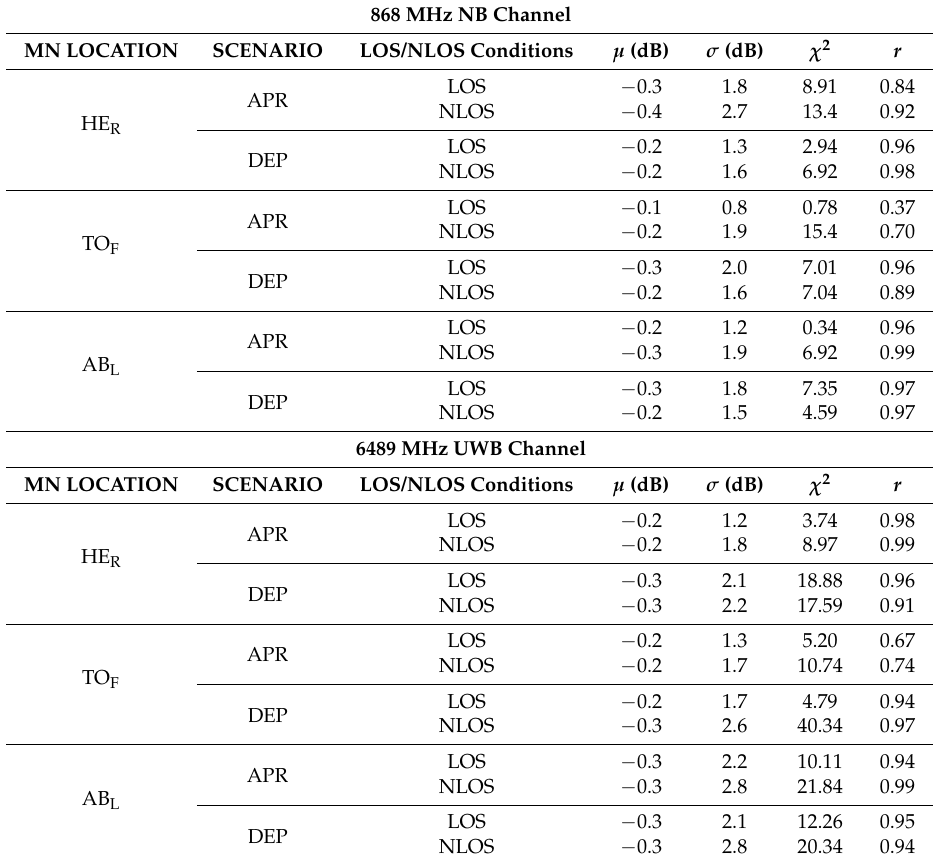
Table 2. The parameters of lognormal PDF fitted to the empirical large-scale fading